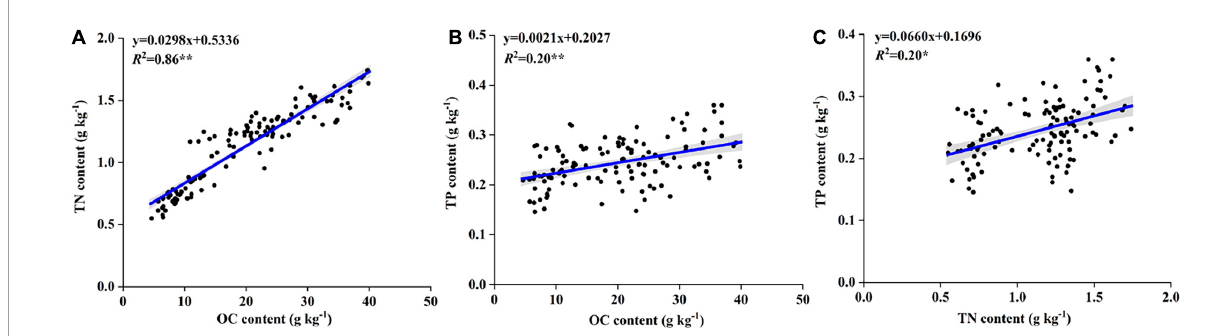
FIGURE4 Relationships of aggregate-associated OC (A) , TN (B) , and TP (C) contents in Chinese fir plantations with different stand types. OC, TN, and TP stand for the contents of organic carbon, total nitrogen and total phosphorus in different aggregate sizes, respectively. ** and * stand for significant correlations at P < 0.01 and P < 0.05, respectively.